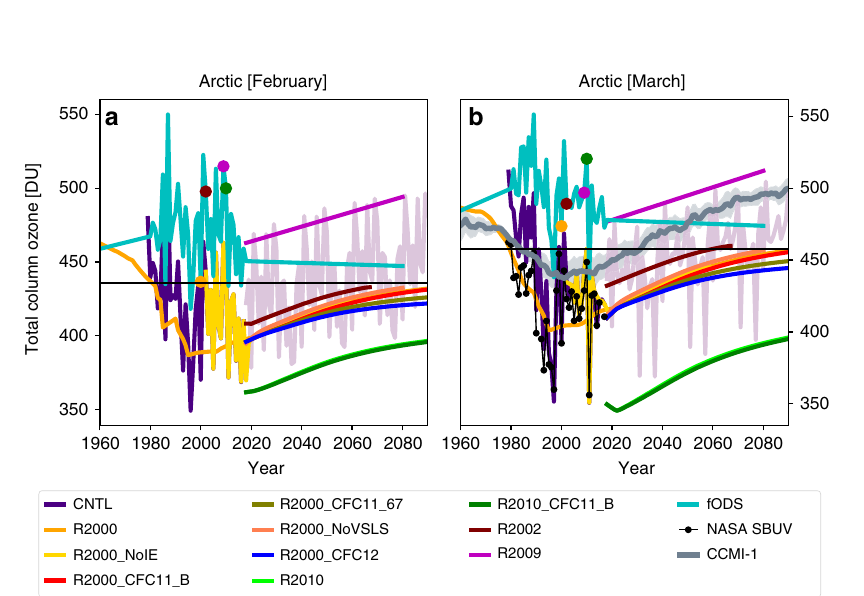
Fig. 4 Past and simulated future Arctic ozone showing the in fl uence of meteorology and additional CFC-11 emissions. Mean column ozone (DU) averaged from 90 o N to 60 o N for a February and b March from TOMCAT simulations CNTL (control), fODS ( fi xed ozone-depleting substances), R2000, R2002, R2009, R2010 (repeating meteorology from 2000, 2002/2003, 2009/2010, and 2010/2011, respectively), R2000_NoIE (no increased CFC-11 emissions), R2000_NoVSLS (no chlorinated very short-lived substances), R2000_CFC11_67 (with constant CFC-11 emissions of 67 Gg yr − 1 ), R2000_CFC11_B and R2010_CFC11_B (with additional CFC-11 emissions from box model for 2000 and 2010/2011 meteorology, respectively) (see legend) from 1960 to 2090. Panel b also shows mean (±1 σ shading) chemistry-climate modelling initiative (CCMI) results from Dhomse et al. 13 and observations from NASA Solar Backscatter Ultraviolet (SBUV) instrument (black line). The coloured dots on the fODS line show the years used for simulations R2000, R2002, R2009 and R2010. The pink line in the background from 2018 to 2090 shows results of the continuation of run CNTL with 20-year repeating